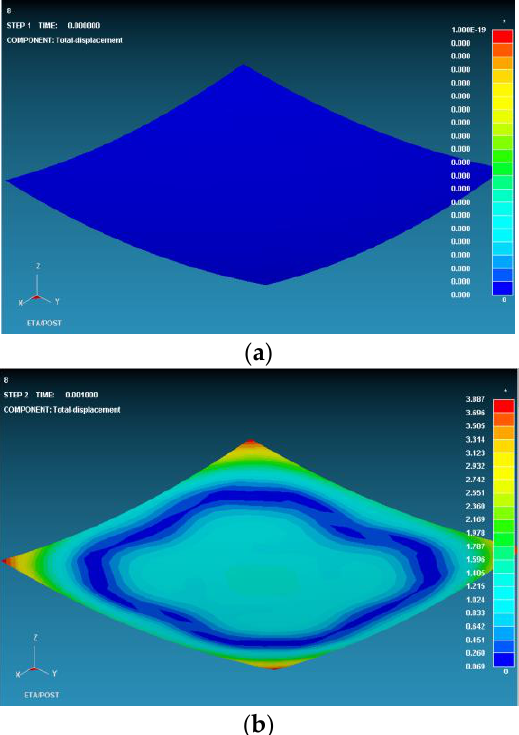
Figure 8. The springback results: ( a ) before springback and ( b ) after springback. Table 4. Results of partial molding simulation